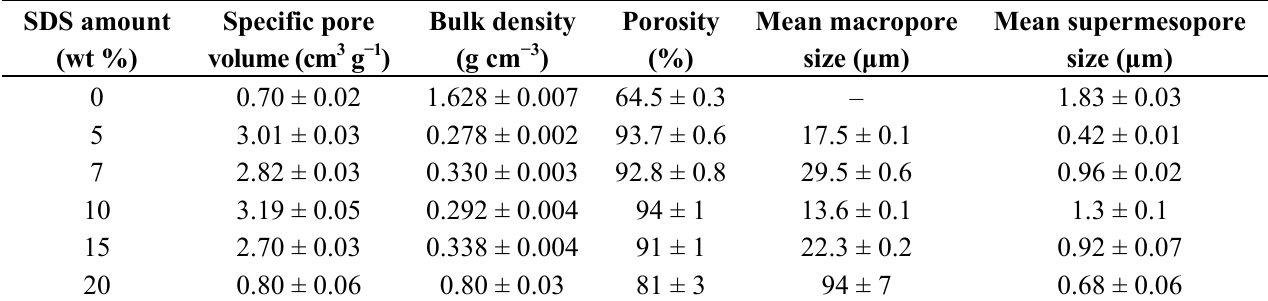
Table 1. Porous characteristics of zirconia foams prepared with different amounts of sodium dodecylsulfate